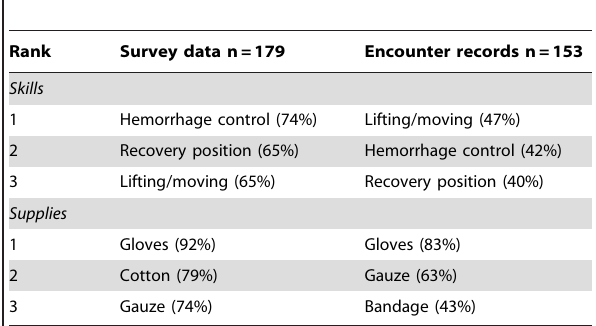
Table 2. Use of specific skills before and six months after the first-aid course.